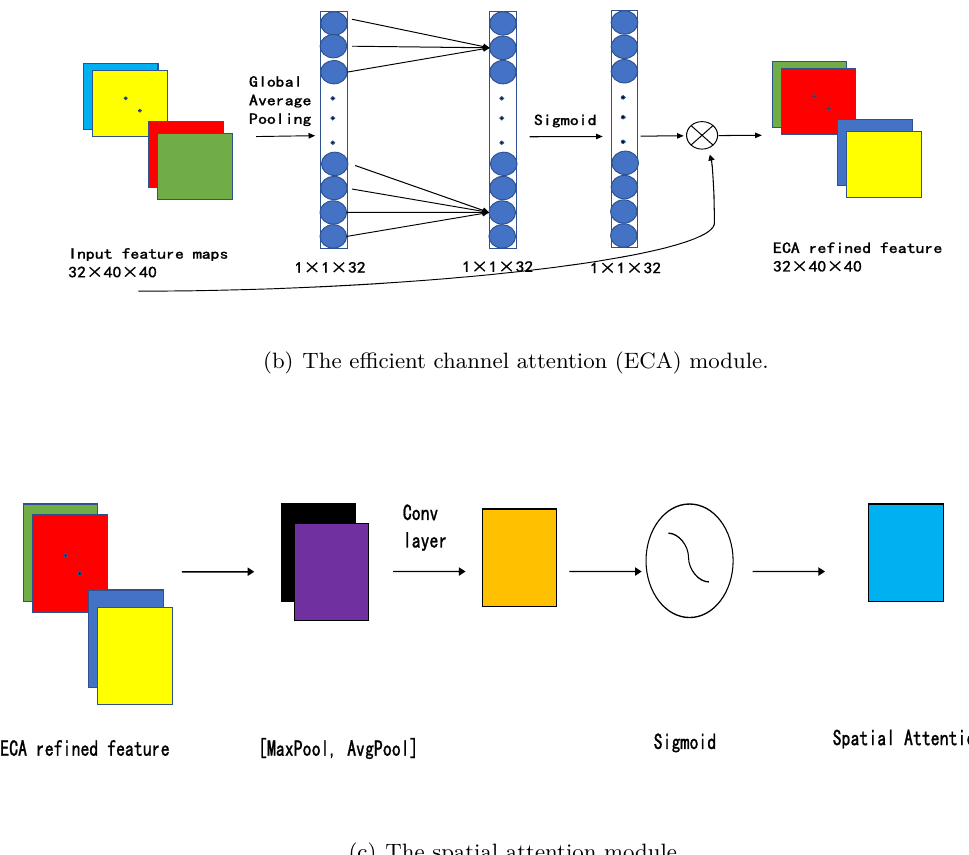
Figure 3 . The attention block designed in our